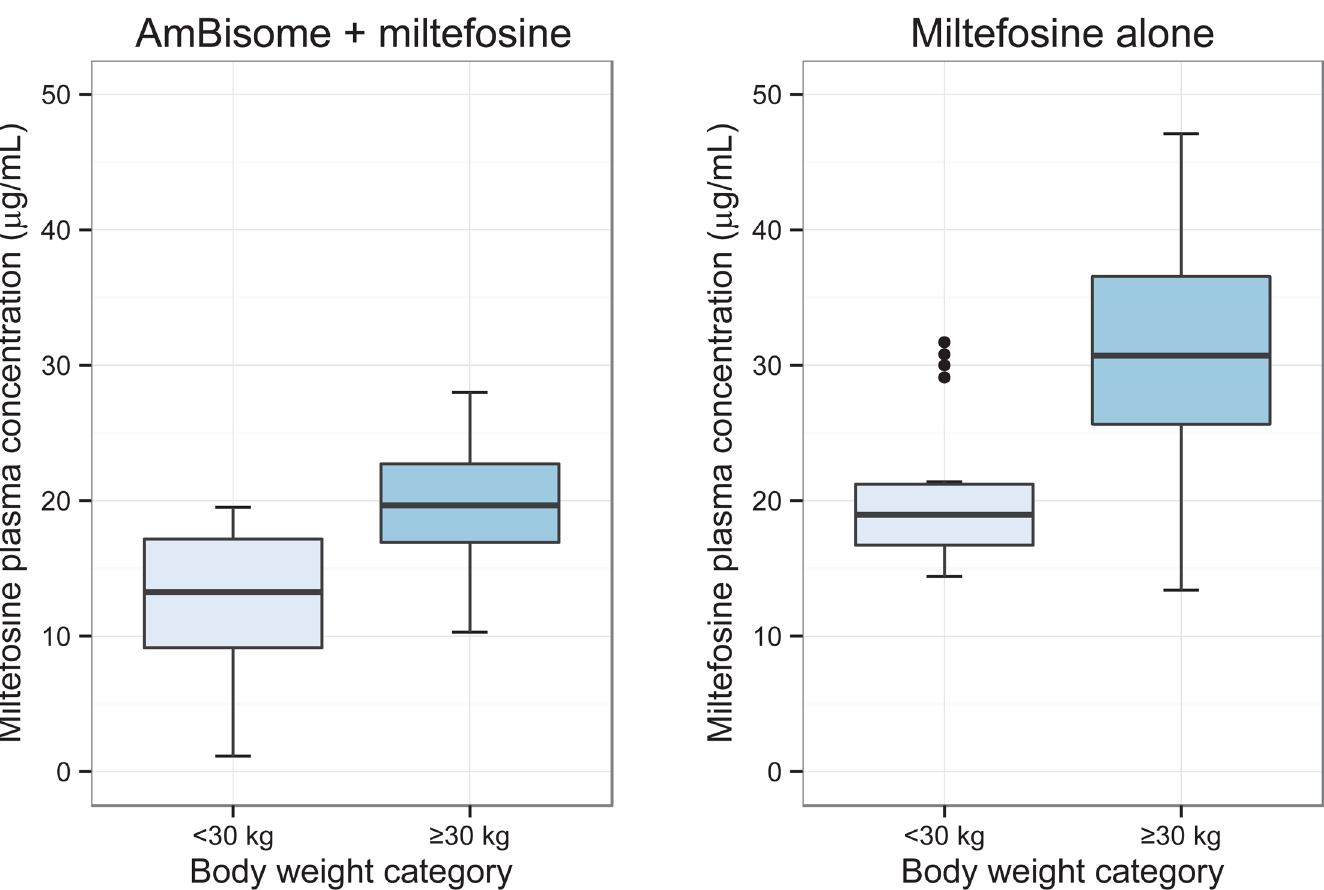
Fig 3. Comparison of the end-of-treatment miltefosine plasma concentrations between body weight categories. The left plot shows the AmBisome + miltefosine arm (10 days of miltefosine), the right plot the miltefosine alone arm (28 days of miltefosine).